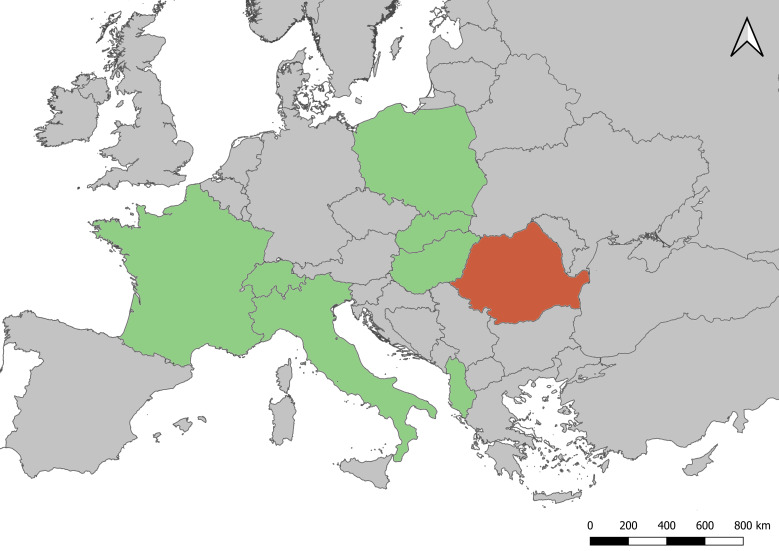
Current geographical distribution of B.
italica in Europe. Green coloured countries with data from literature by Szentivanyi et al. 2016 and our first record for Romania with red colour.